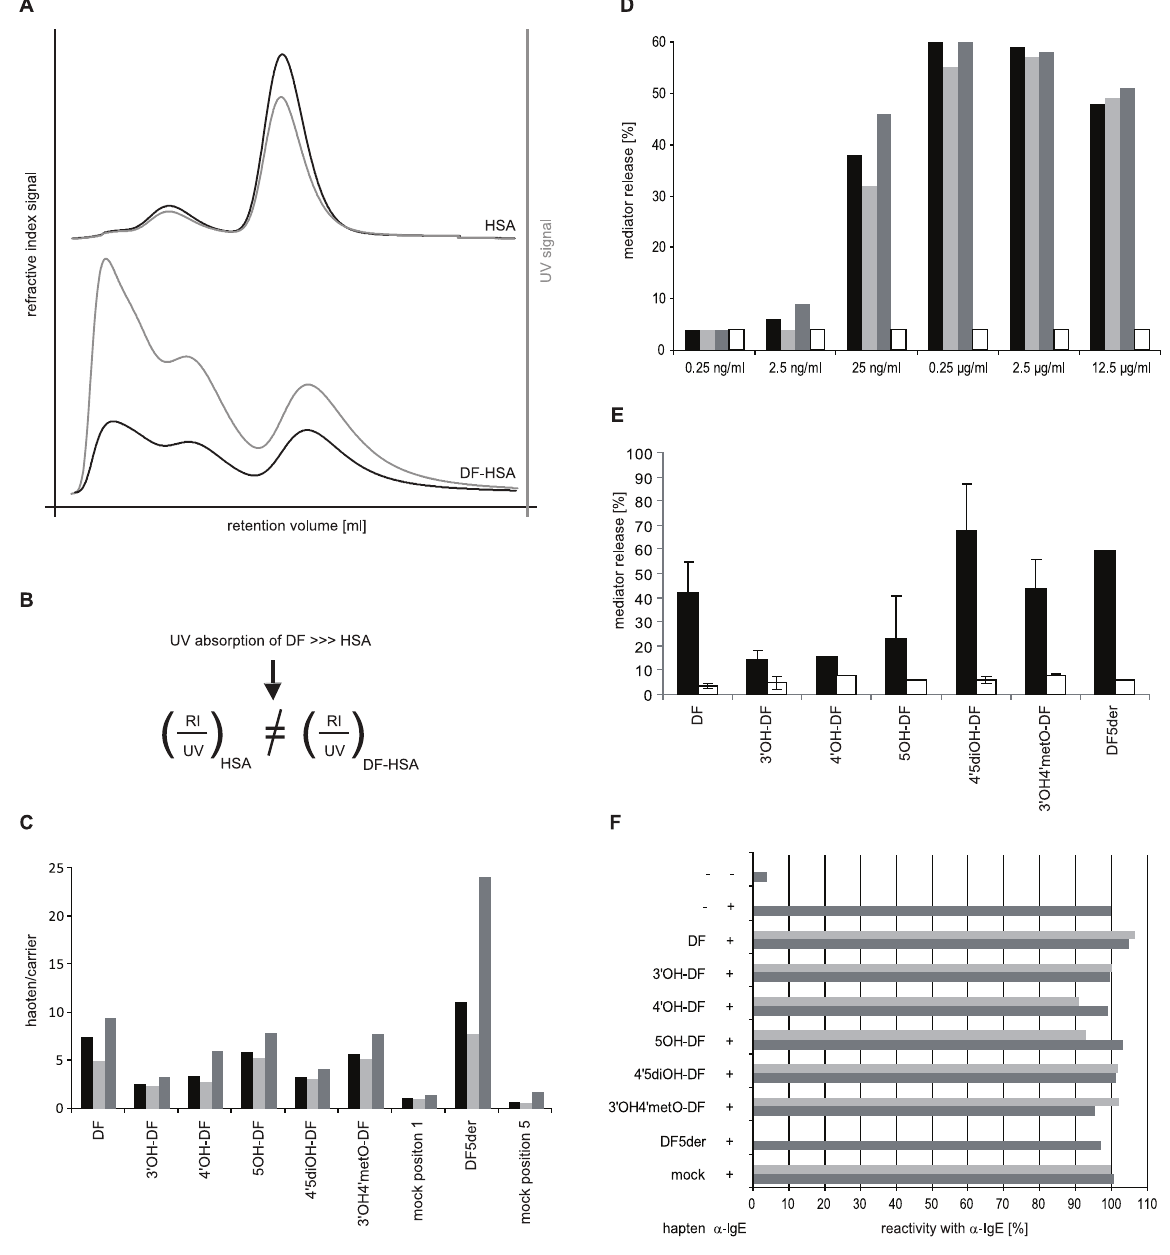
Figure 2. Characterization of hapten-HSA conjugates. (A) Coupling degree of eluting HPSEC fractions derived from hapten-HSA conjugates was determined from (B) the ratio of refractive index (black) to UV signal (gray) resulting in (C) several haptens per carrier molecules for all conjugates compared to respective mock controls; determined coupling degree for total, monomeric, and aggregated HPSEC fractions are illustrated in black, light, and dark gray, respectively. (D) Determination of optimal concentration of DF-HSA conjugate for Fc e RI-crosslinking/mediator release; determined values for total, monomeric, and aggregated HPSEC fractions are illustrated in black, light, and dark gray, respectively, mock controls in white. (E) All hapten-HSA conjugates (dark gray) showed mediator release (n=1–4) from rat basophil leukemia cells when incubated with sera from immunized mice; mock controls in light gray. (F) Investigation of cytotoxicity of hapten-HSA conjugates coincubated at 1 (dark gray) and 20 m g/ml (light gray) with anti-IgE by basophil activation test (100% without conjugate).